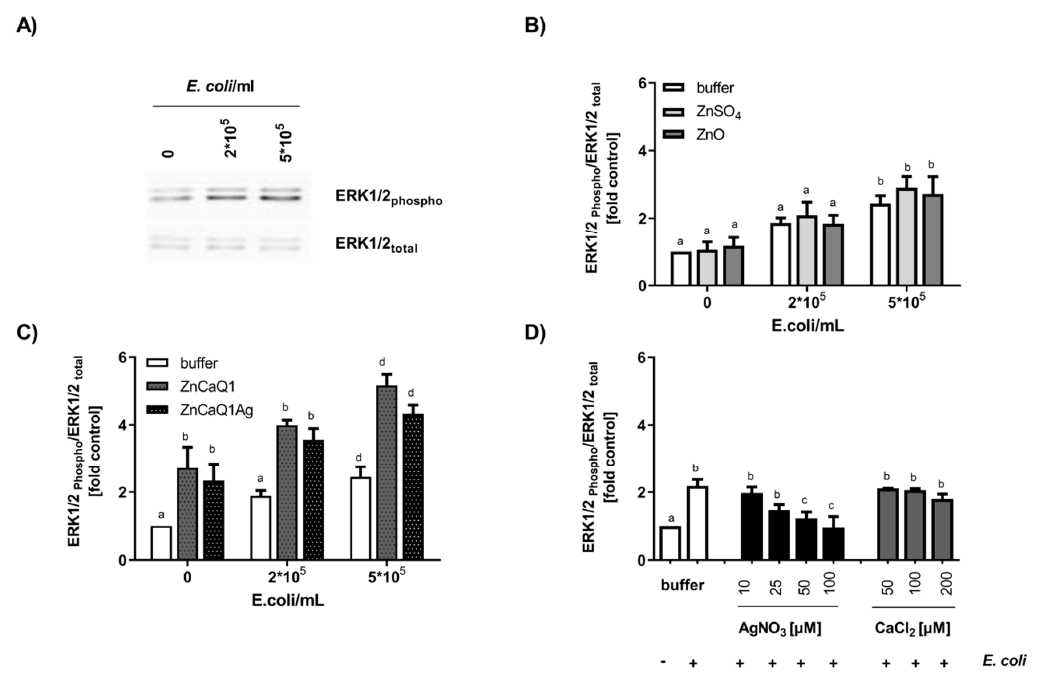
Figure 4. E ff ect of aerogel swelling supernatants on TLR4-induced ERK1 / 2 phosphorylation in RAW 264.7 cells. Macrophages were stimulated with E. coli for 30 min in the presence or absence of aerogel swelling supernatants or metal salt solutions generated in SBF-albumin. Whole cell lysates were separated by SDS-PAGE and subjected to Western blot detection applying antibodies against phosphorylated or total ERK1 / 2. ( A ) Representative Western blot images of phosphorylated-ERK and total ERK protein ( B , C ) Aerogel swelling supernatants and zinc solutions were applied with a final zinc concentration of 100 µ M. ( D ) E ff ect of AgNO 3 or CaCl 2 on E. coli -induced ERK1 / 2 phosphorylation. Data are presented as means ± SEM of three independent experiments. (Bars sharing letters are not significantly di ff erent; repeated measures ANOVA with Tukey’s multiple comparisons post-hoc